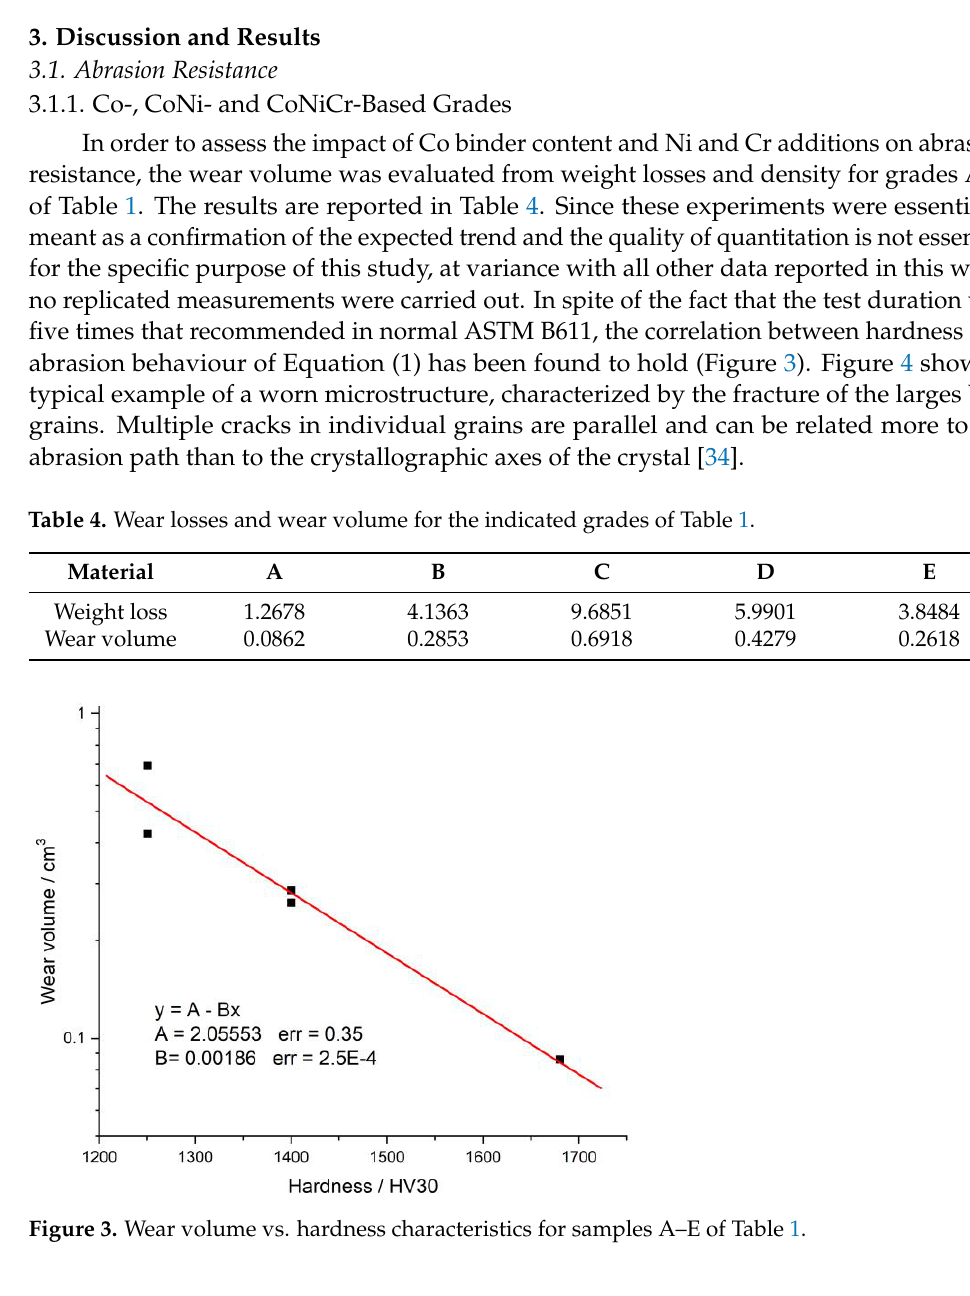
Figure 4. SEM micrographs of grade C of Table 1: ( a ) pristine surface, ( b ) after abrasion test (the arrow shows the friction direction). 3.1.2. Impact of Systematic Variations of Cr Content Cr addition, keeping the content of the main component of the metallic binder con- stant, progressively increases the hardness (Figure 5a), always exhibiting a parabolic de- pendence [4,35]. The Ni-base grades obey a similar behaviour, highlighting a continuous increase in hardness with the increase of the Cr addition, even if the specific increment seems to be smaller. Furthermore, Ni-base grades show hardness values that are signifi- cantly lower than those of Co-base ones. The abrasion results of the investigated grades — complied in Figure 5b — are coherent with the expected correlation with hardness values (Figure 5a): the amount of removed mass in each sample is inversely proportional to the hardness value. The same behaviour was also found for Ni-base grades, opening up the